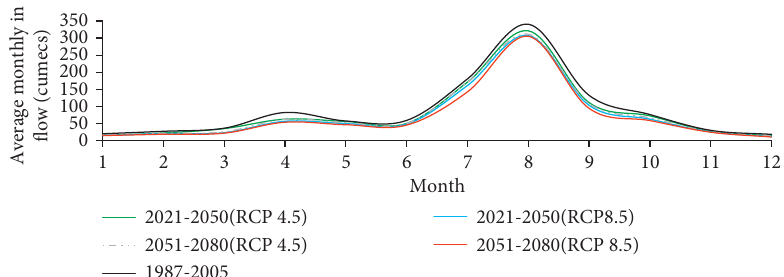
Figure 17: Kesem reservoir inflow discharge at different time horizons.